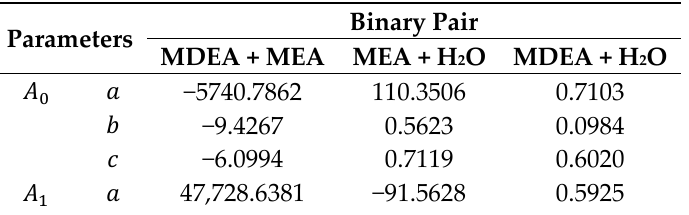
𝑖𝑛 𝑖=0 for the excess